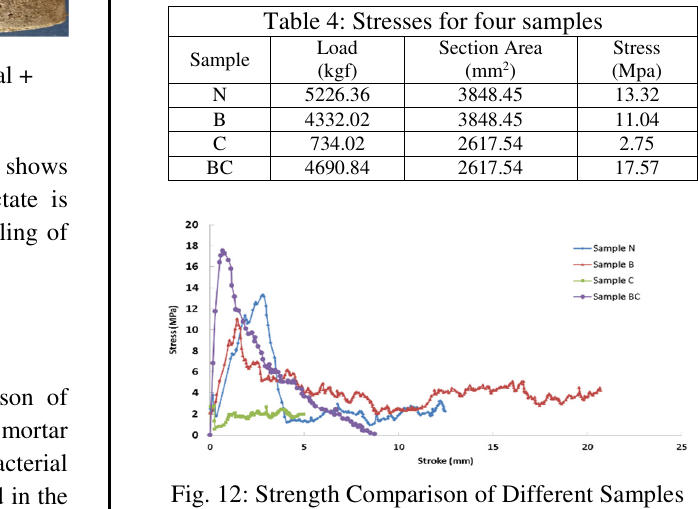
Fig. 12: Strength Comparison of Different Samples